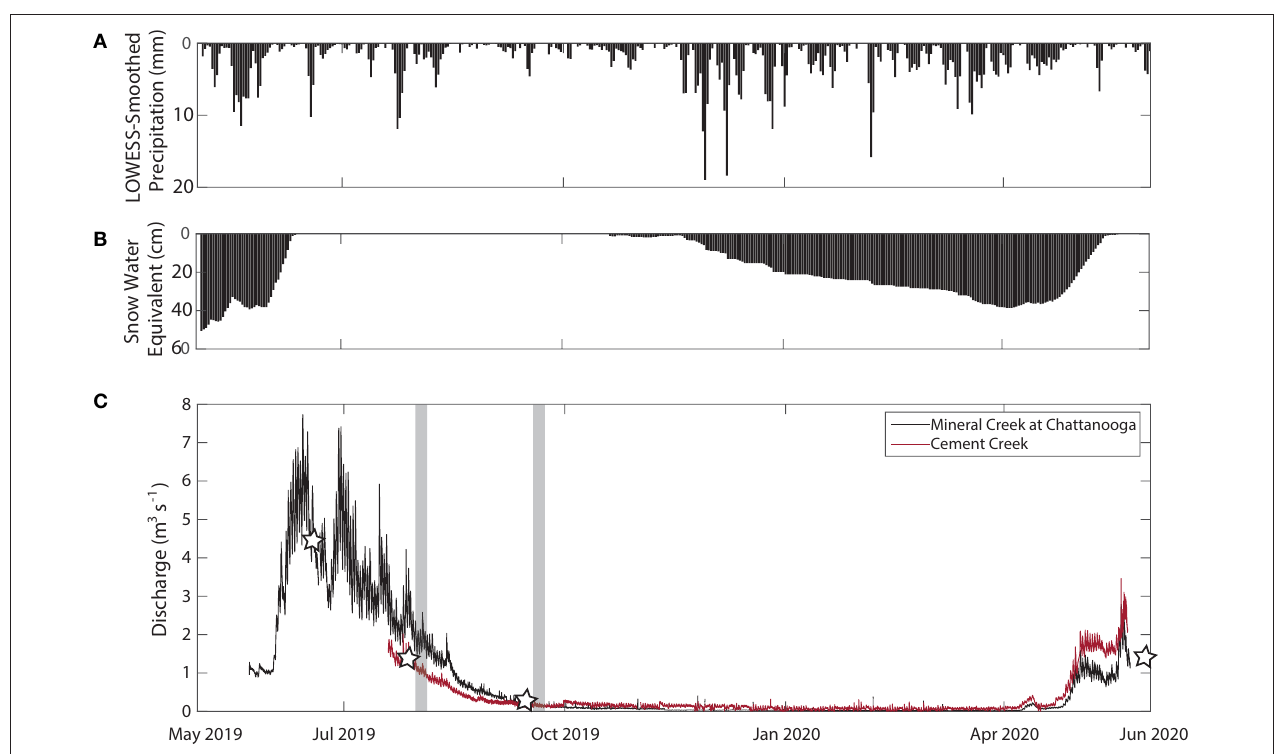
FIGURE 8 | (A) Precipitation from the Gladstone Treatment Plant smoothed using a RLOWESS filter with a filtering window of 3 days, (B) snow water equivalent data from the Mineral Creek SNOTEL site (USDA, 2020), and (C) hydrographs for the stilling wells installed in Mineral Creek near Chattanooga Fen and Cement Creek downstream of Prospect Gulch. The gray-shaded bars represent the period during which tracer tests were completed at high and low flows. The stars represent times of hyporheic zone well